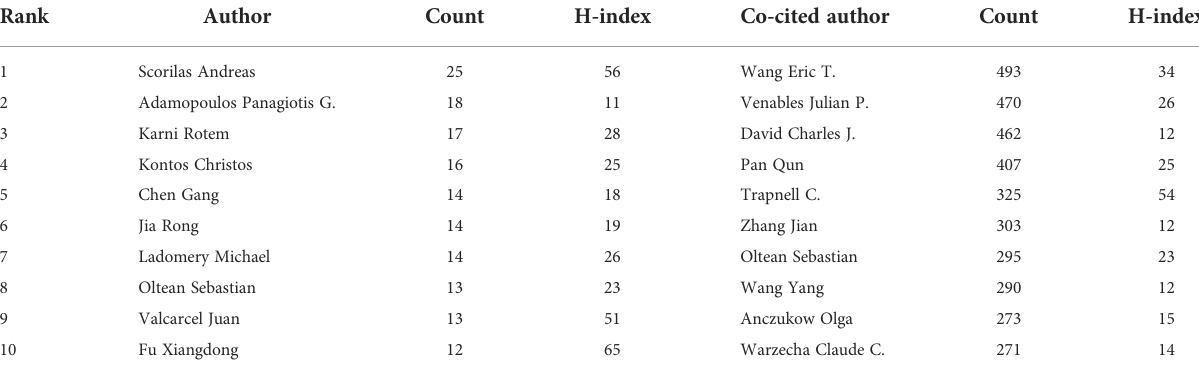
TABLE 2 Top 10 authors and co-cited authors related to alternative splicing of cancer.